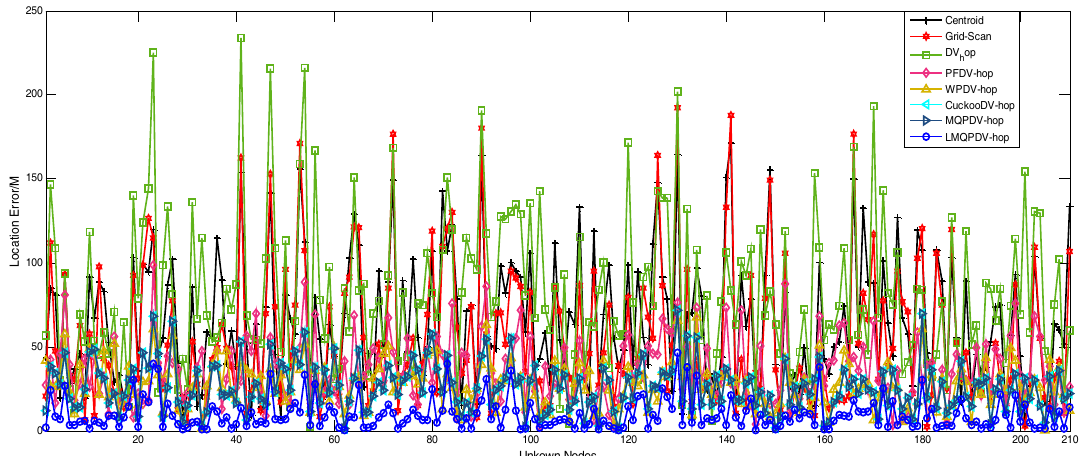
Figure 21. The location error of LMQPDV-hop when the anchor proportion was 30% and R = 250 for WSN #1.